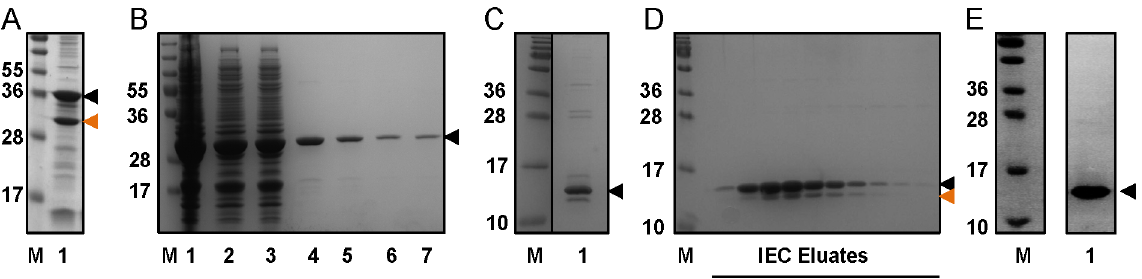
Figure 2. Purification of recombinant human ATG16L1 coiled-coil. (A) GST-CCD1-FLAG-6His expression produces a truncated product (orange arrowhead). (B) Glutathione sepharose purification of GST-CCD2-FLAG-6His. 1 – total cell lysate, 2 – soluble extract, 3 – unbound flow through, 4–7 successive elution fractions. (C) CCD2-FLAG-6His following removal of the GST tag by TEV cleavage (lane 1). (D) Elution fractions of CCD2-FLAG-6His after anion exchange. The position of the truncated protein is marked by an orange arrowhead. (E) CCD3-FLAG-6His (lane 1) is highly pure and shows no evidence of truncation following glutathione sepharose affinity purification, TEV cleavage and hydrophobic interaction chromatography. In all panels the black arrowhead marks the bands representing the expected size of the ATG16L1 construct; M denotes